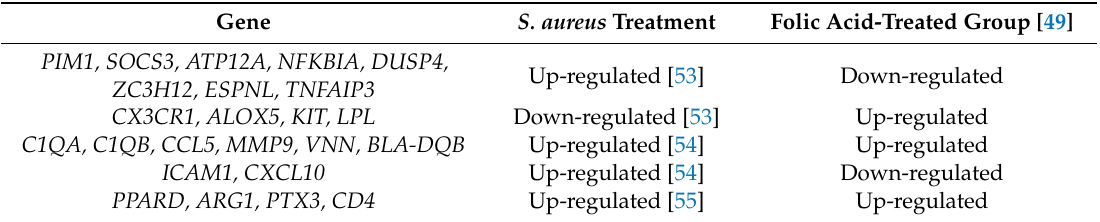
Table 1. Comparison of gene regulation status in folic acid-treated and S. aureus -infected mastitis cows. Gene